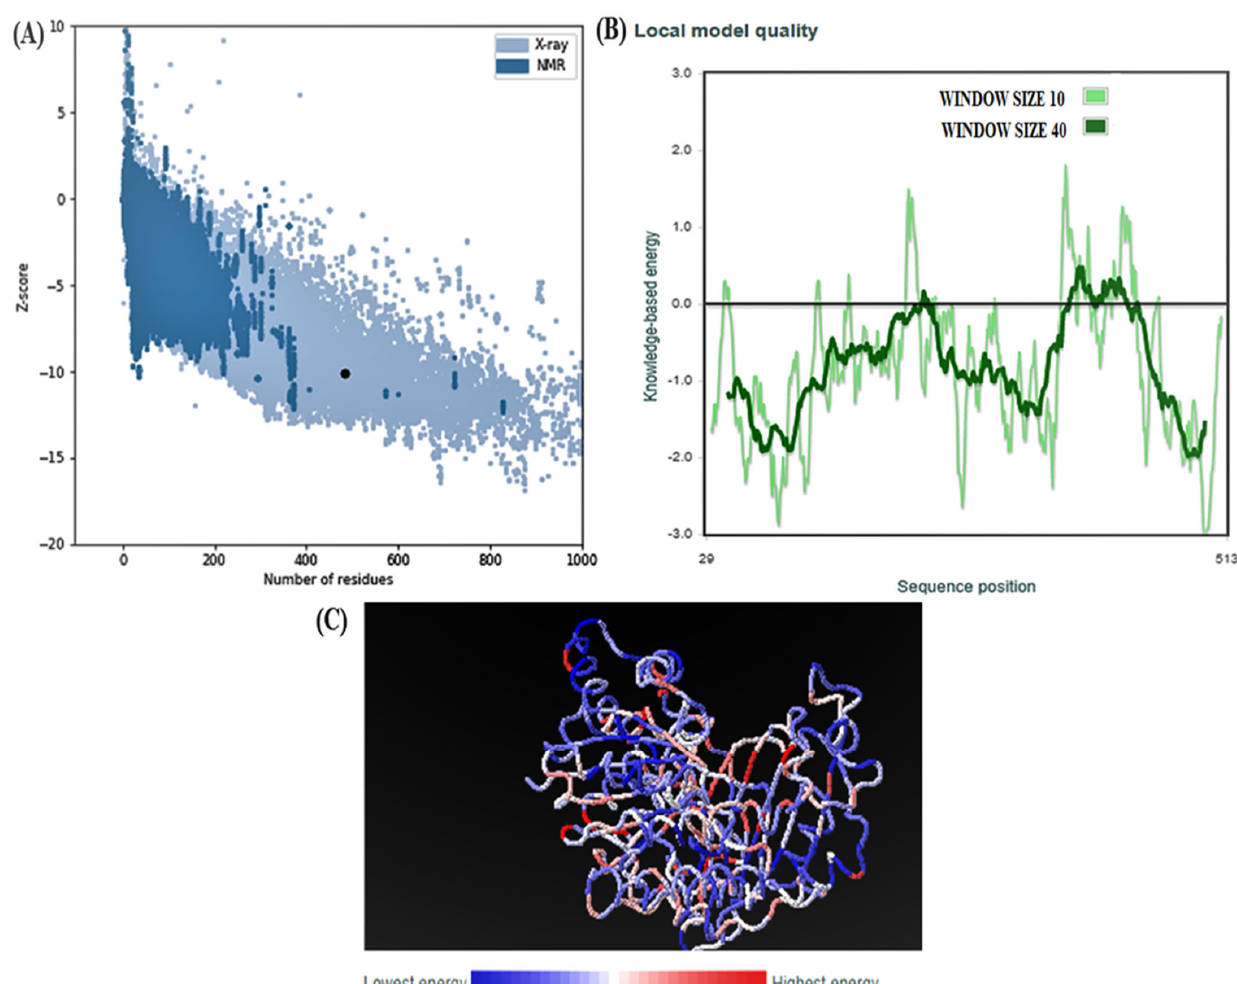
Figure 6. Human G6PD domain Z-score and plot of residue scores. ( A ) ProSA-web z -scores of all protein chains. ( B ) Energy plot. ( C ) Highest and Lowest energies of protein.